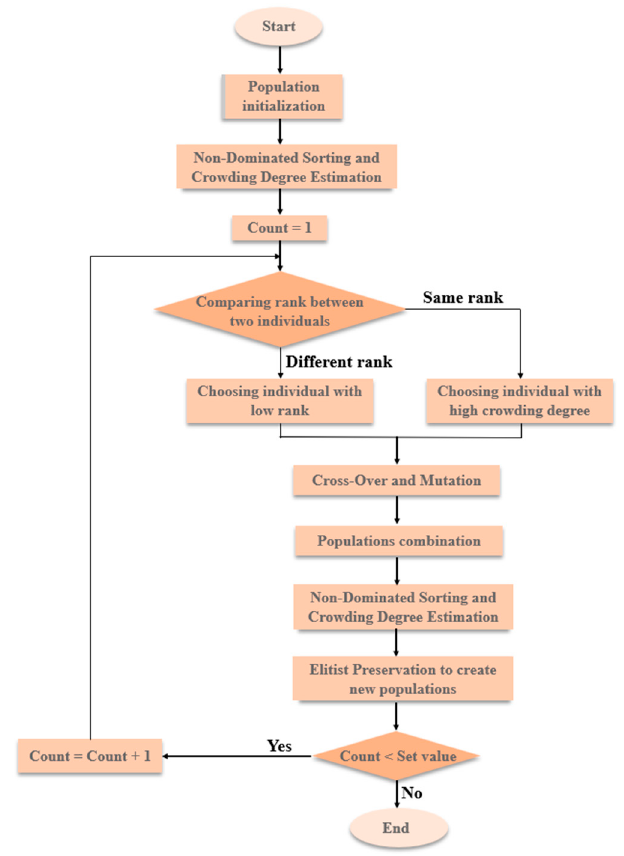
Figure 8. The algorithm flow for NSGA-II.